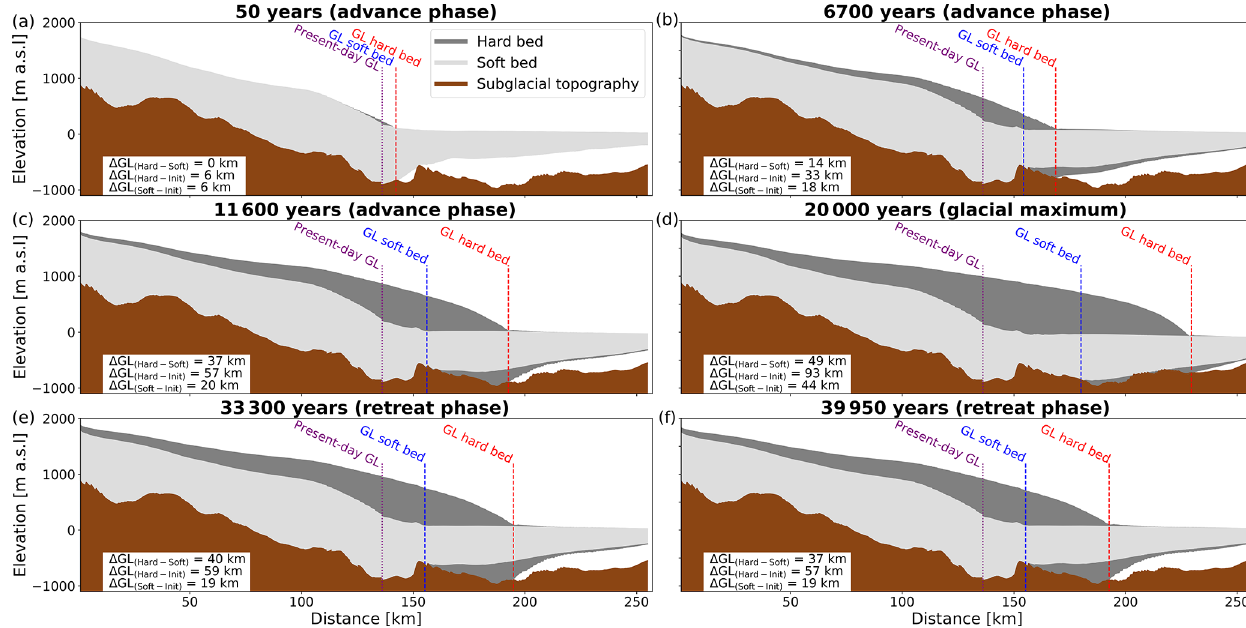
Figure 10. Difference in ice sheet geometry and grounding-line position along a flow line (A–A (cid:48) in Fig. 1) for the soft- and hard-bed simulations. (a) – (d) show differences in the advance phase, and (e, f) show differences in the retreat